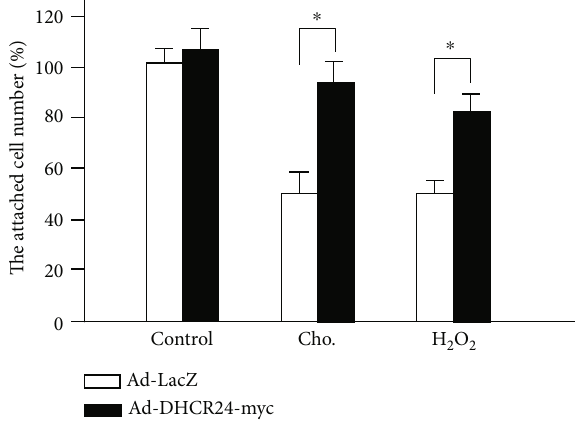
Figure 5: MIN6 apoptosis induced by both cholesterol and H is inhibited by overexpression of DHCR24. MIN6 cells were exposed to cholesterol (250 × dilution) and H postadenovirus infection. The adherent cell number was calculated as percentage of cells infected with Ad-LacZ in the control group. Mean ± S : D : ( n = 3 ); ∗ p < 0 : 05 vs. Ad-LacZ.